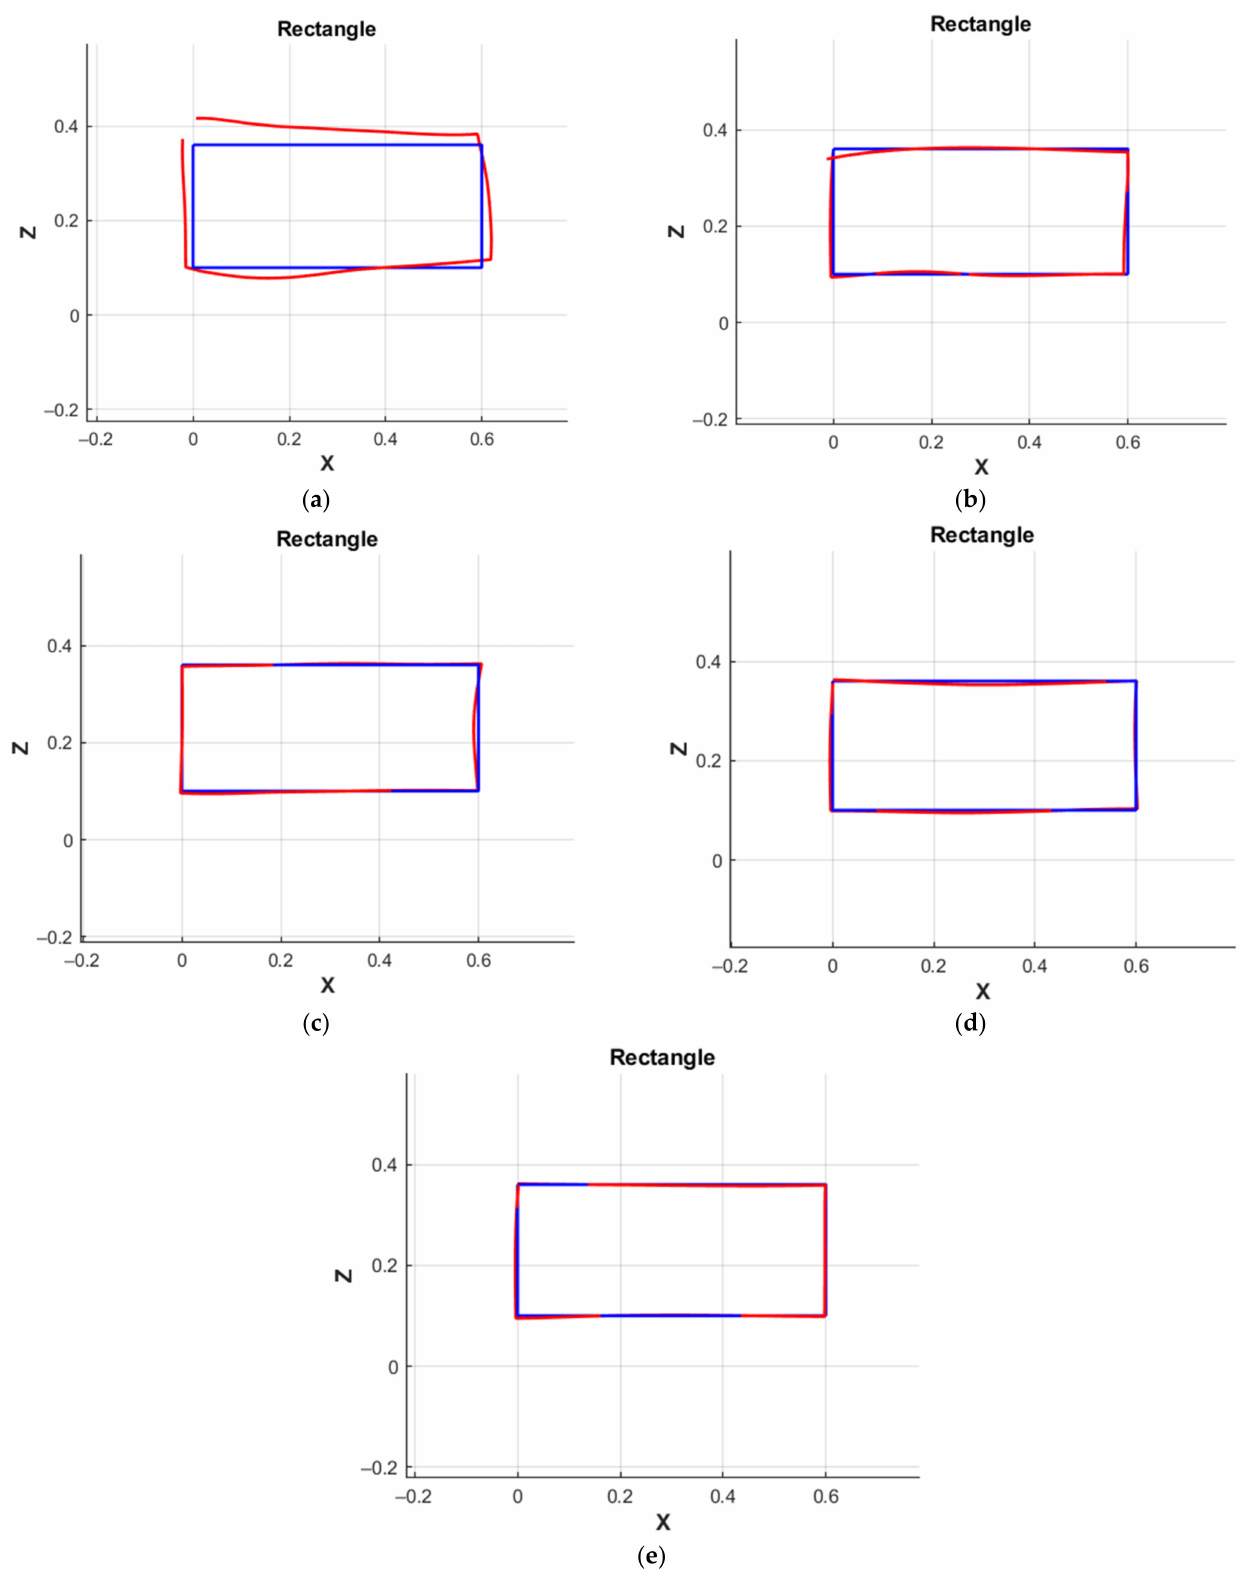
Figure 14. Simulation of the movement of the manipulator along the rectangle: ( a ) MATRIX NN 1; ( b ) MATRIX NN 2; ( c ) MATRIX NN 3; ( d ) MATRIX NN 4; ( e ) the correctional